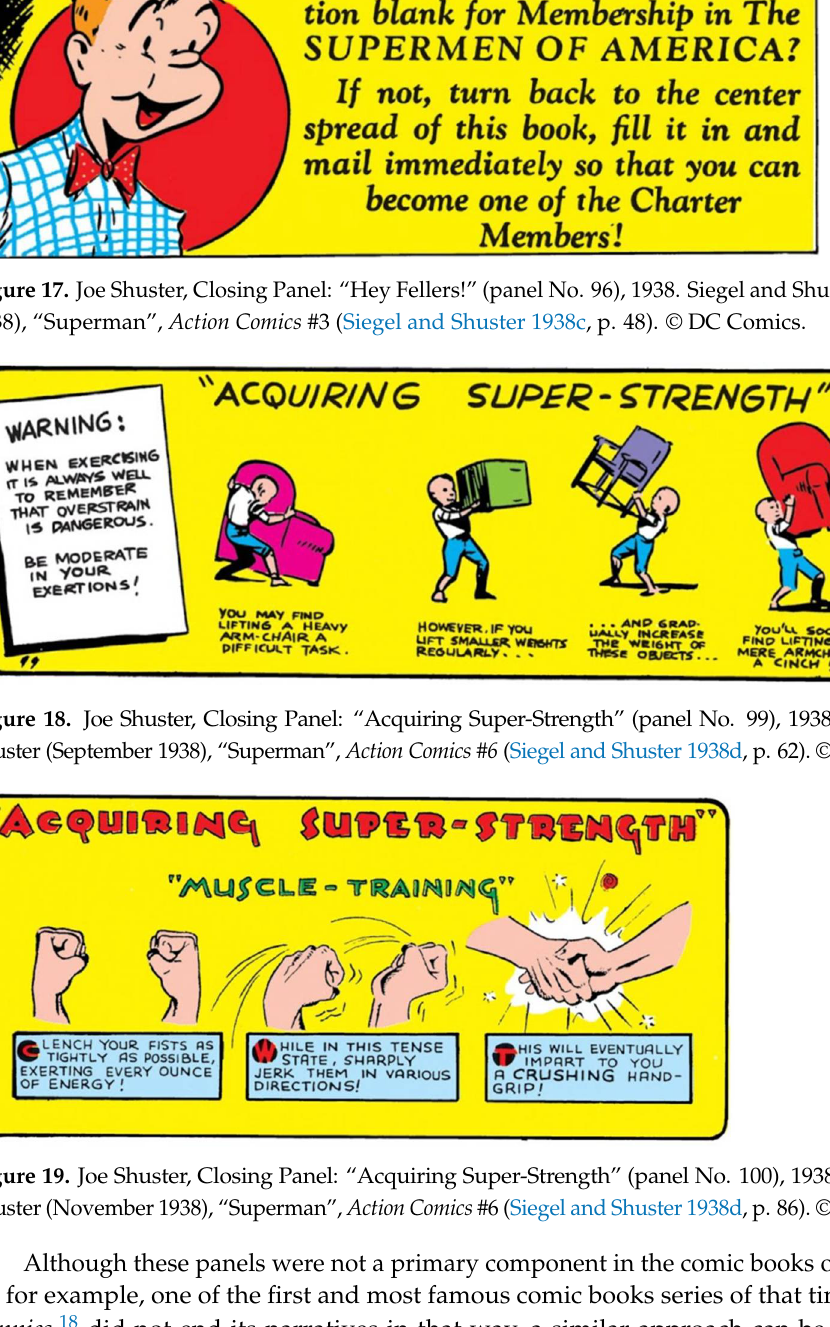
Figure 16. Joe Shuster, Closing Panel: “Attention all American Youth!” (panel No. 101), 1938. Siegel and Shuster (July 1938), “Superman”, Action Comics #2 (Siegel and Shuster 1938b, p. 34). © DC Com- ics.